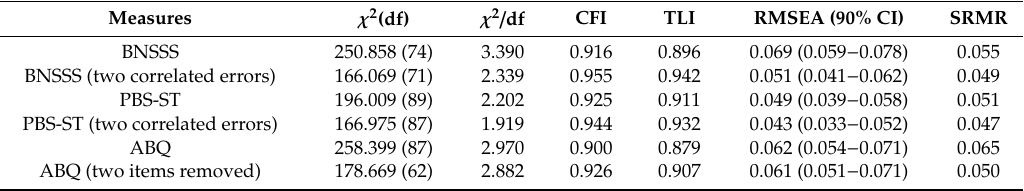
Table 1. Fit indices of the measures derived from confirmatory factor